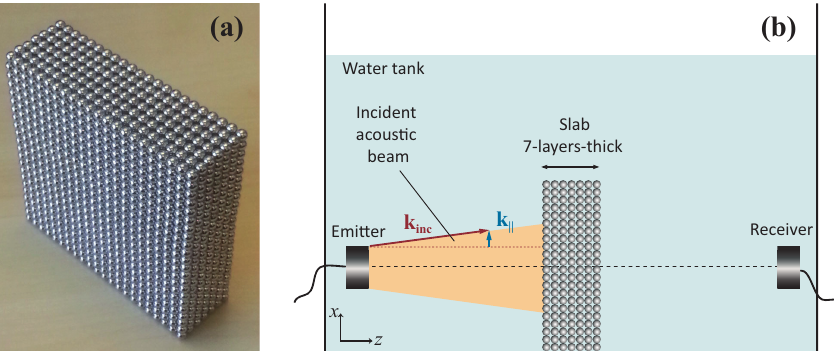
Figure 1. ( a ) the finite three-dimensional (3D) sc structure made of touching magnetic spheres of diameter d = 5 mm, with dimensions 11 cm × 11 cm × 3.5 cm, before its immersion in water; and ( b ) schematic representation of the experimental setup. The emitter-beam angular spreading (shaded region) is characterized by a wavevector component parallel to the (001) surface of the slab, k (cid:107) , varying from zero (normal incidence) to a maximum value depending on